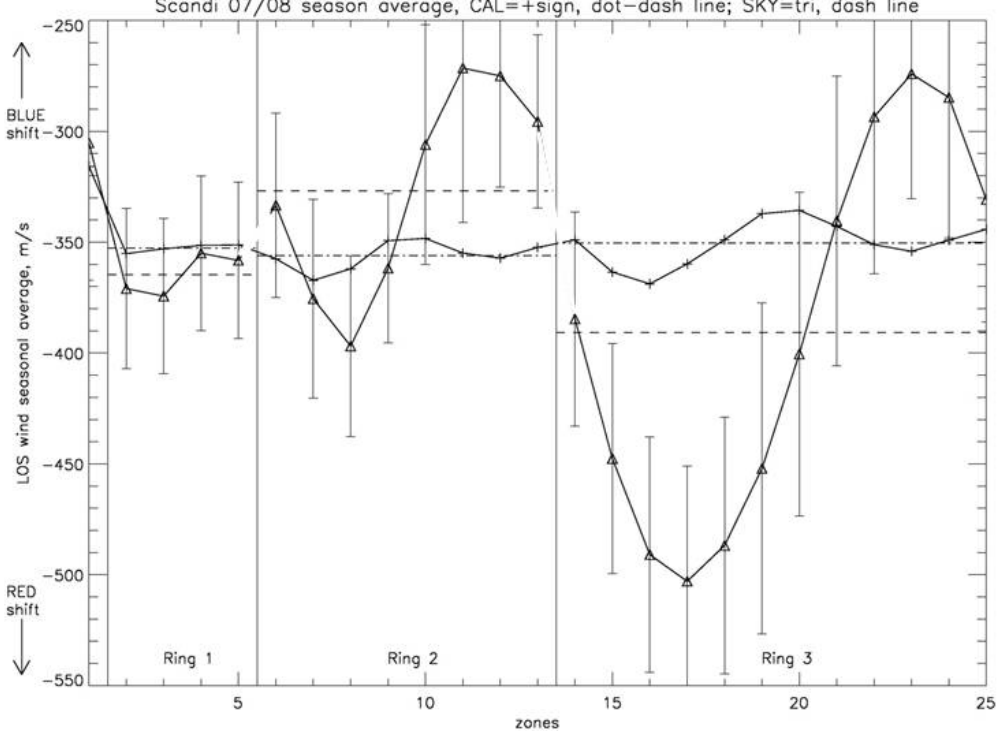
Fig. 7. Average position (December 2007–January 2008) of the CAL (stars) and SKY (triangles) peaks for each zone shows a sinusoidal variation around each ring. The peak positions are offset from an arbitrary baseline. The horizontal lines indicate the average position for each ring: CAL=dot-dash; SKY= dashed. The vertical lines indicate the standard deviation of the data. The small standard deviation of the CAL data indicates good thermal stability for SCANDI, while that of the SKY data indicates the natural variability of thermospheric winds.